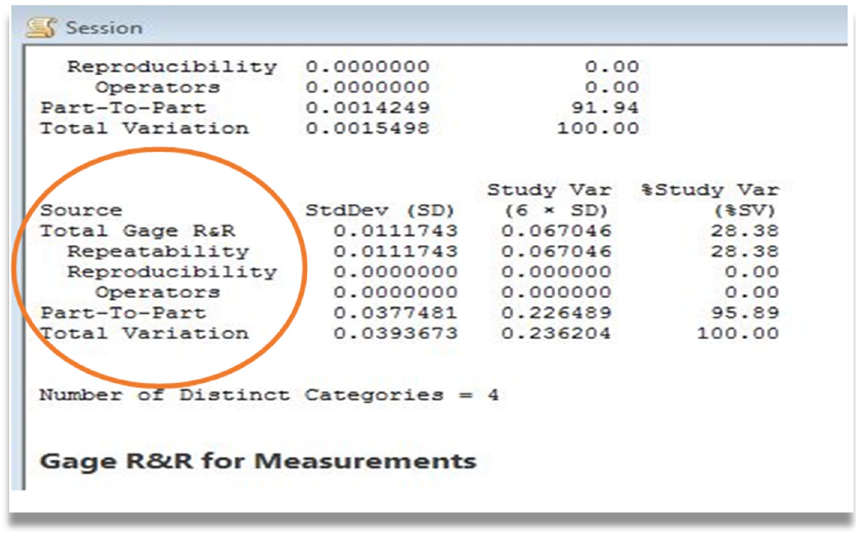
Figure 7. Measures rapport—ANOVA.